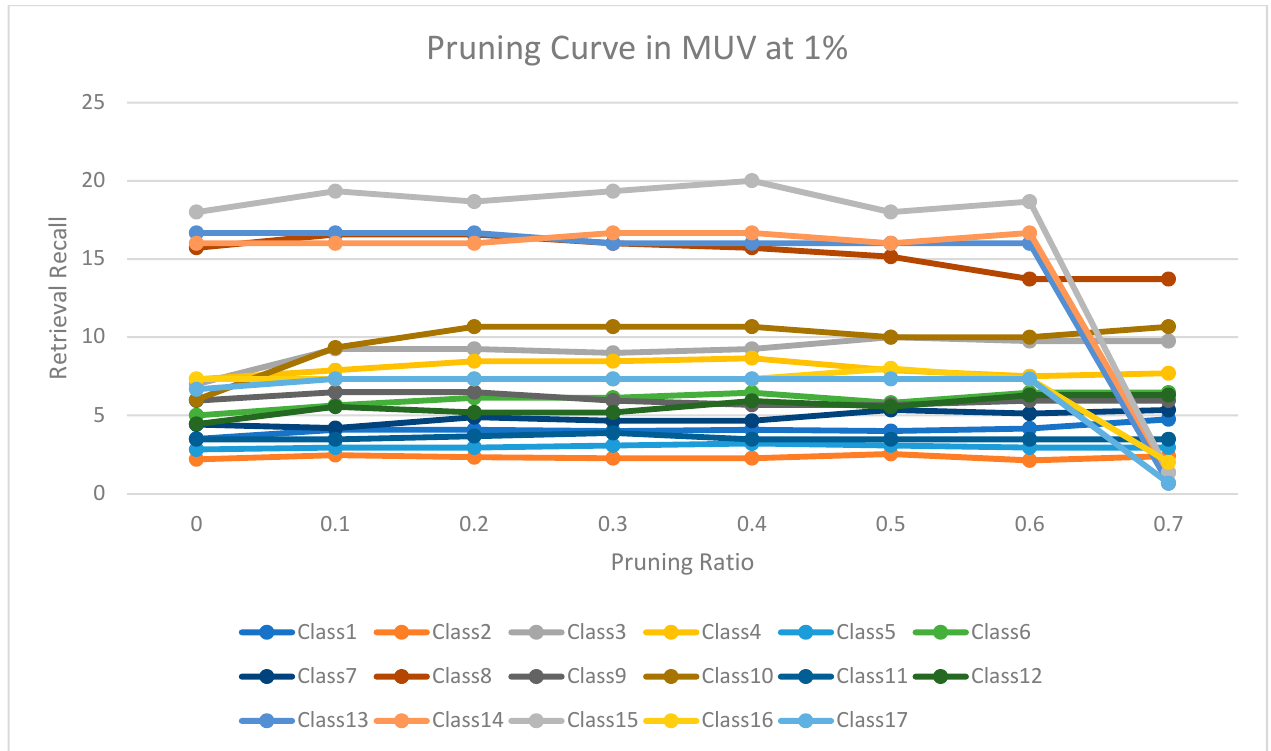
Figure 10. The level of retrieval recall values at different percentages of pruning at the top 1% in MUV dataset.